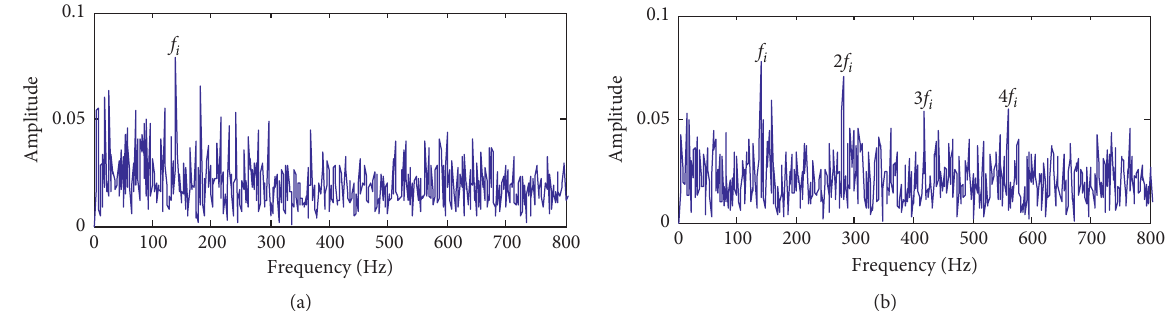
Figure 9: Comparison results of SSC2 by CYCBD with changed parameters: (a) the envelope spectrum of deconvolution signal with parameters a � 140.6 and L � 50; (b) the envelope spectrum of deconvolution signal with parameters a � 139.8 and L � 70.